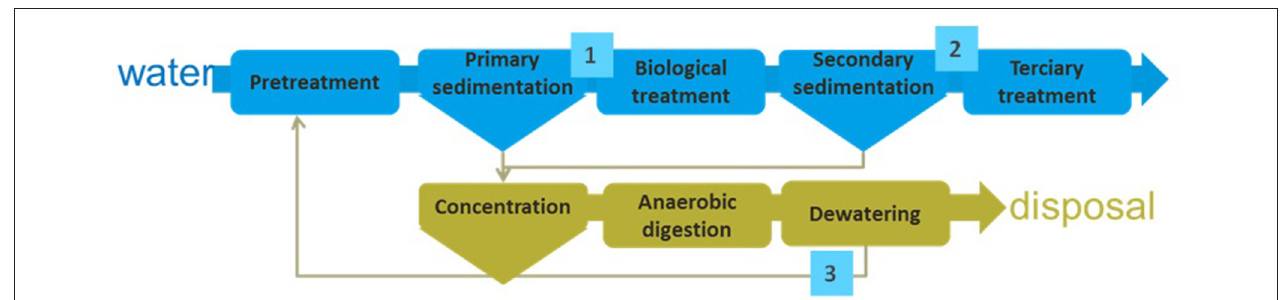
Frontiers in Sustainable Food Systems |